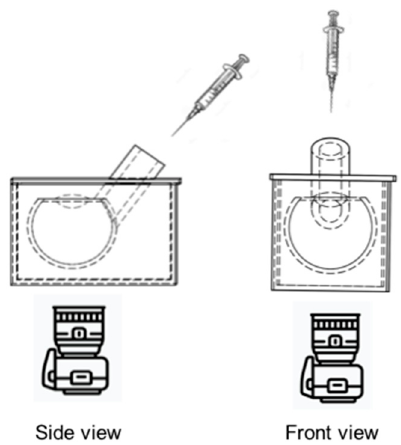
Figure 1. Schematic diagram of 3D printed model scaled to the geometry of an adult human eye. The vitreous cavity was completely filled with different vitreous substitutes. Dye (50 µL) was injected into the cavity via a 30G needle placed in the inlet of the model to standardize needle depth. Side ( left ) and front view ( right ) images acquired with a digital SLR camera (Canon EOS 7D). The camera was mounted with a 60 mm lens. Images were recorded at a speed of 25 Hz or every 40 ms.